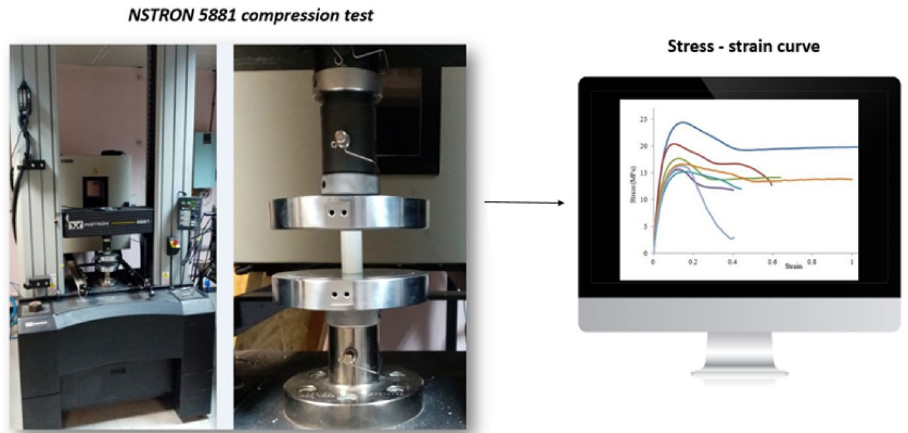
Figure 4. Steps to find the strength, Young’s modulus, and elongation.